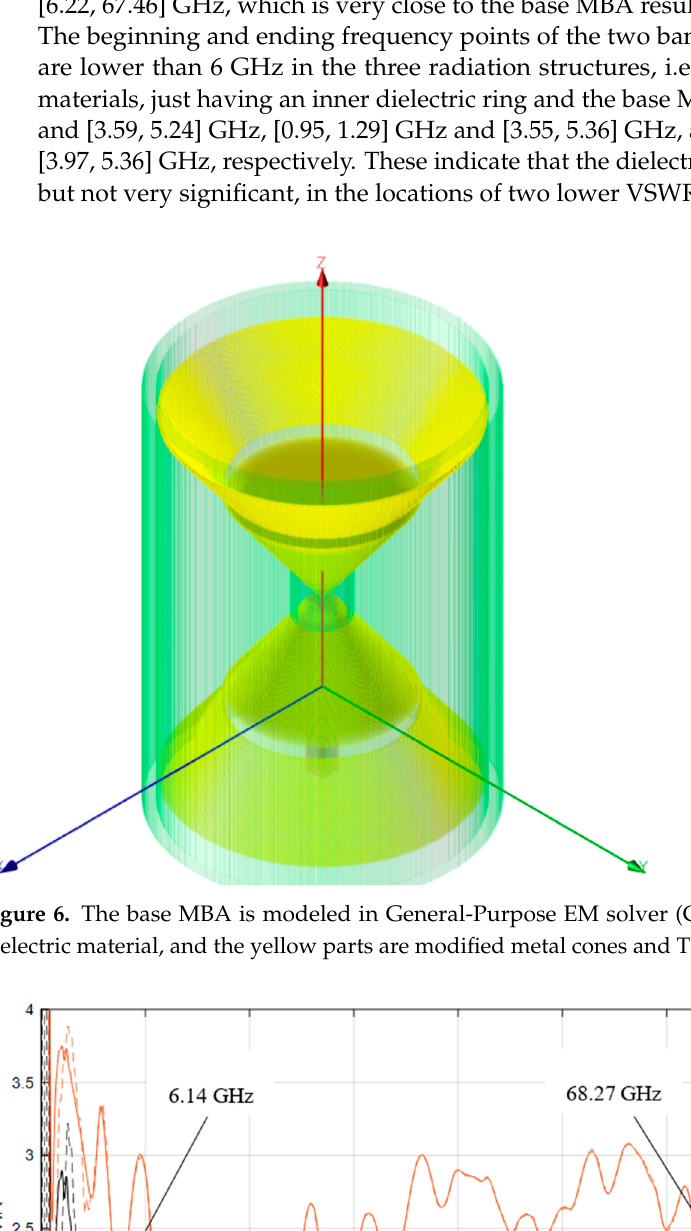
Figure 8. Details of voltage standing wave ratio (VSWR) and return loss from 0 GHz to 6 GHz of the base MBA showed solid lines in Figure 7. ( a ) ( b ) Figure 9. The input characteristics of the radiation structures ( a ) the base MBA without dielectric ring and cover, and ( b ) the base MBA just with the inner dielectric ring.